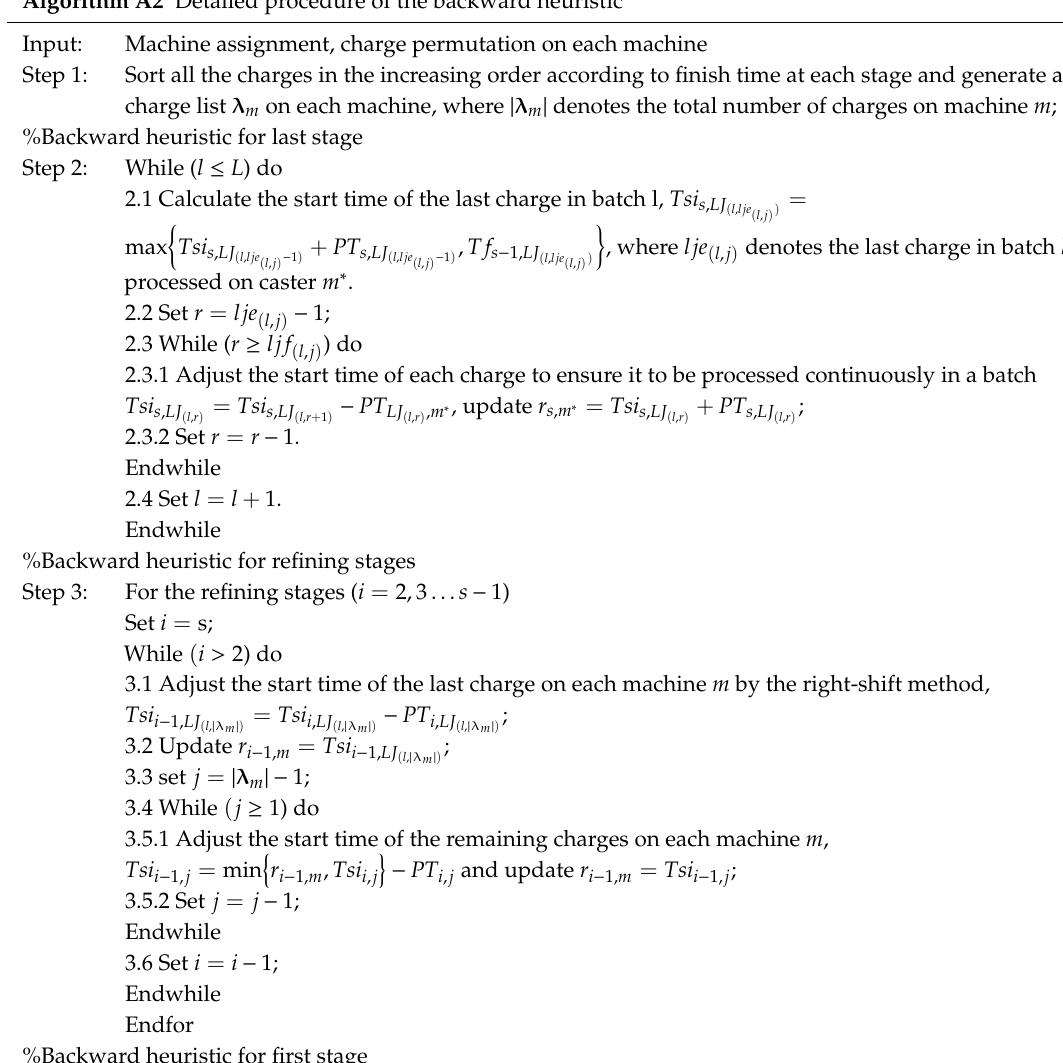
Algorithm A2 Detailed procedure of the backward